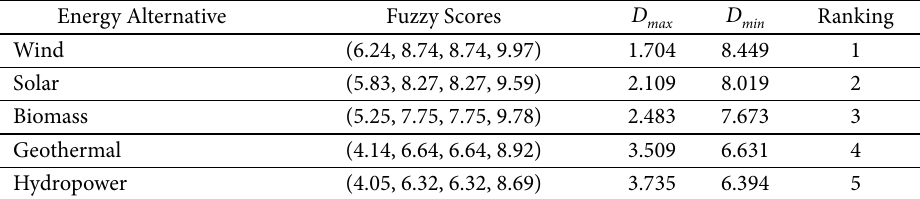
Fig. 6. membership functions of fuzzy scores for renewable energy alternatives Table 4. The ranking results for renewable energy alternatives